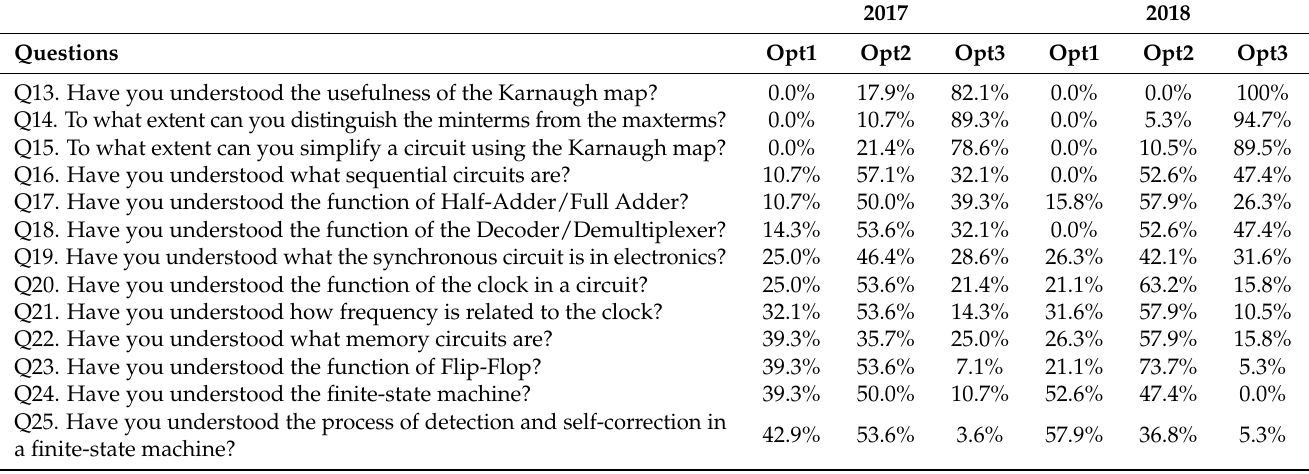
Table A2. Questionnaire